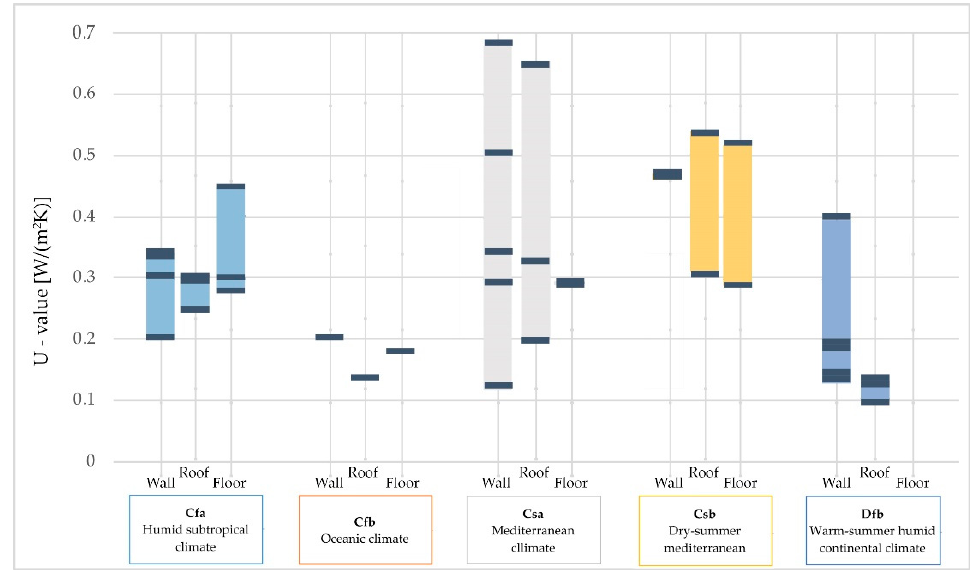
Figure 24. Optimal EEMs for opaque envelope—multi-family buildings.